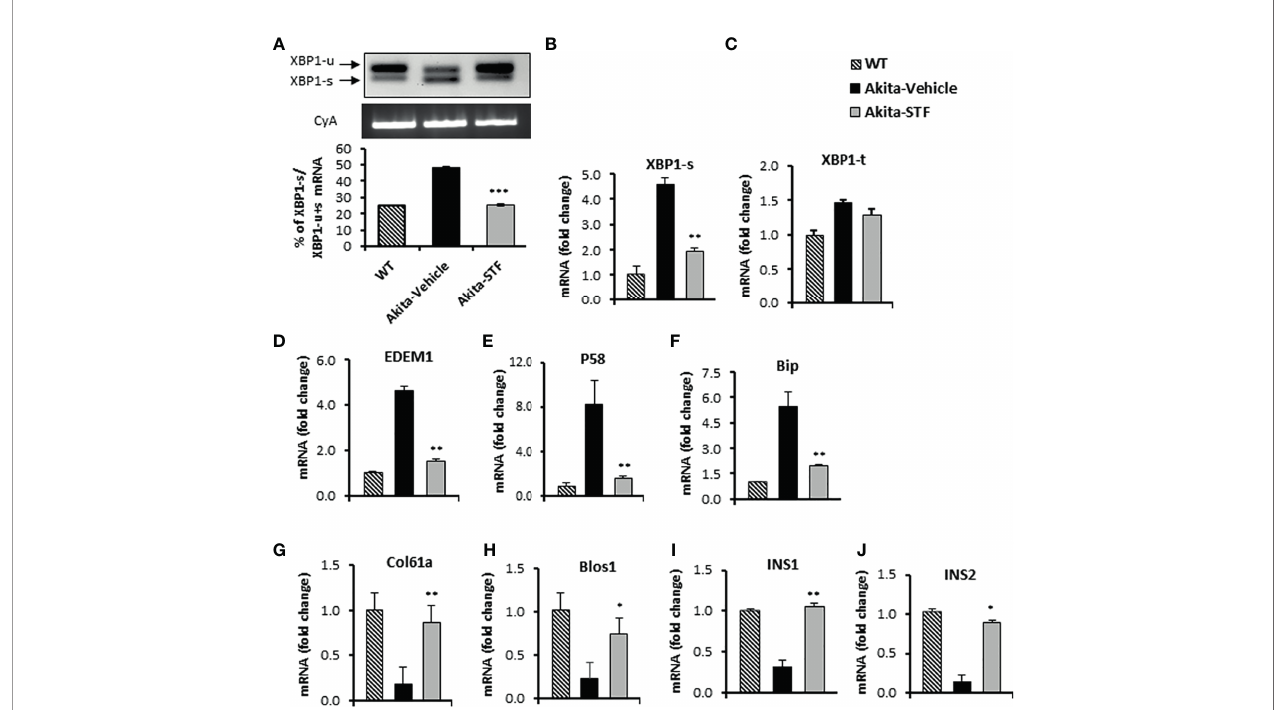
FIGURE 3 | STF inhibits IRE1 a RNase activity. (A) XBP1 mRNA levels were analyzed in islets isolated from Akita mice treated with STF or vehicle as in by RT-PCR and the products were resolved by agarose gel electrophoresis. The full length (unspliced, XBP1-u) and spliced (XBP1-s) forms of XBP1 mRNA were indicated and quanti fi ed by ImageJ program. Cyclophilin A mRNA was used as an internal control. (B – J) mRNA levels for indicated genes were analyzed in islets isolated from Akita mice treated with STF or vehicle by qRT-PCR. The results are expressed as fold change and are representative of 3 independent experiments. *P < 0.05, **P < 0.01, and ***P < 0.001 compared to Akita-vehicle group. Bars indicate